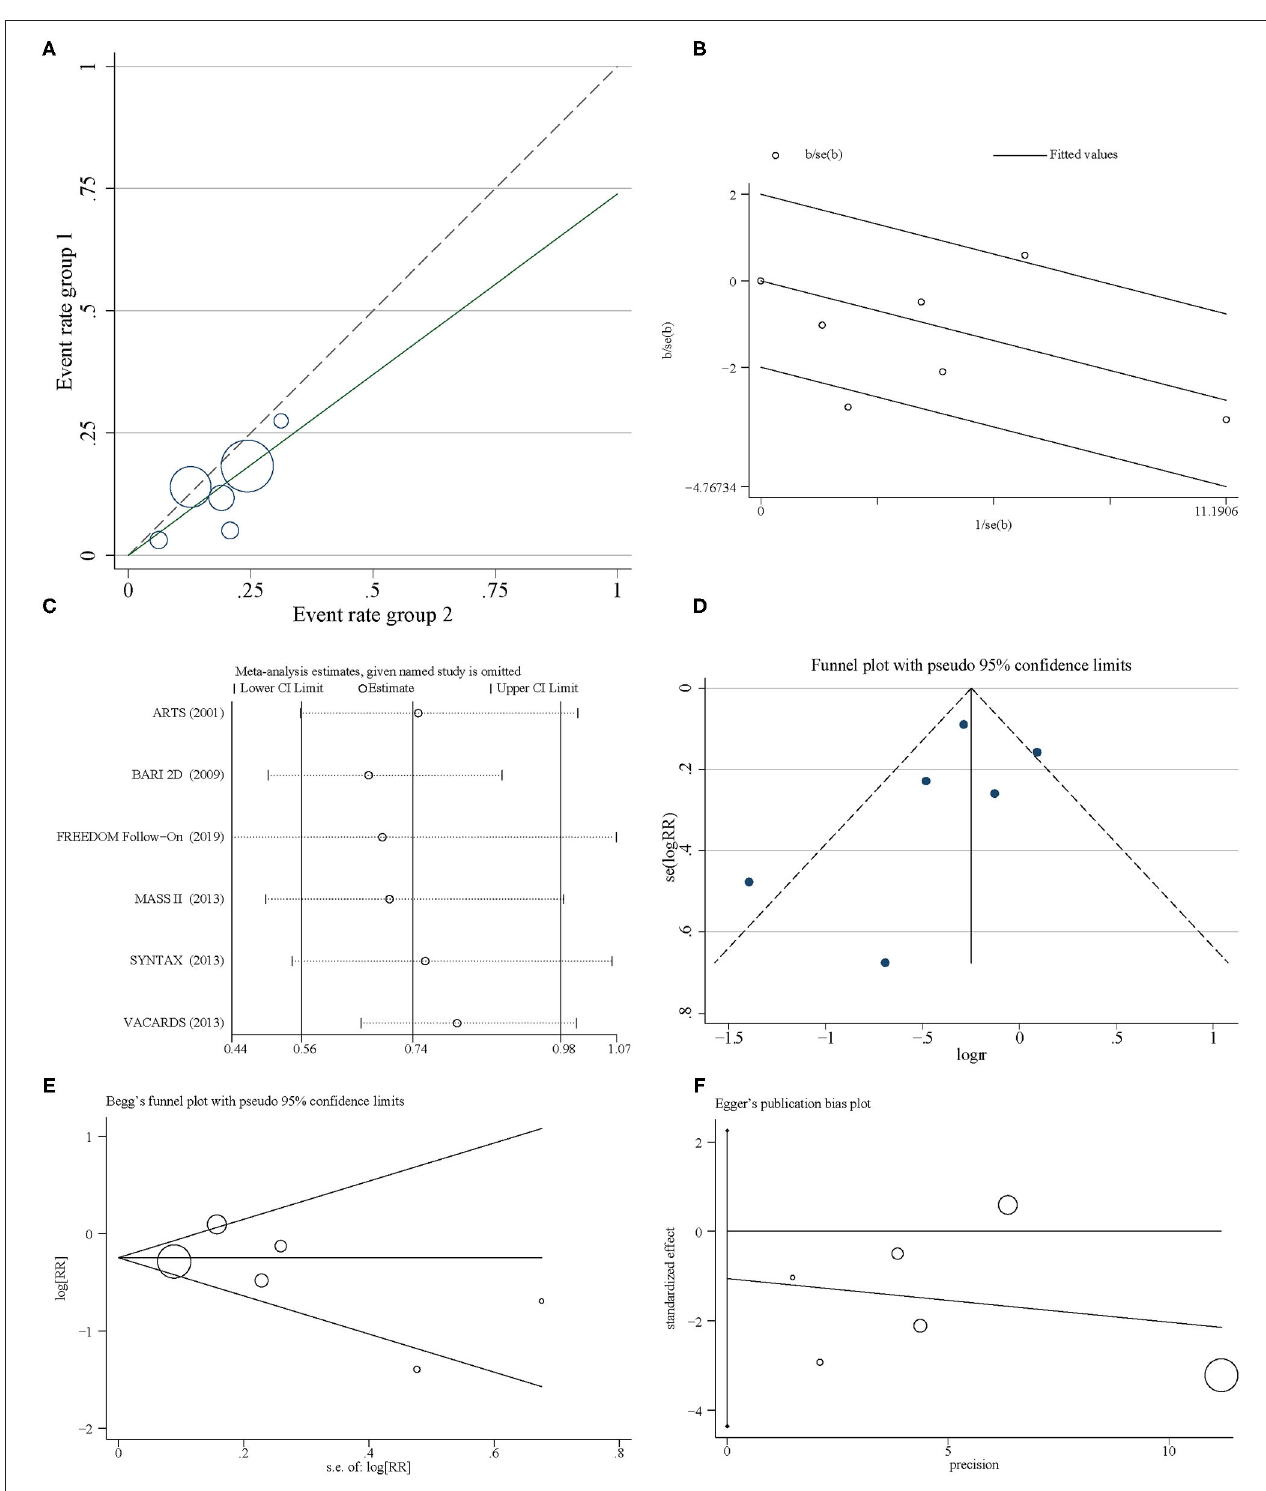
FIGURE 3 | Heterogeneity and sensitivity analysis. (A) L’Abbe plot. (B) Galbraith Radial plot. (C) Sensitivity analysis. (D) Funnel plot. (E) Begg’s plot. (F) Egger’s plot. T2DM revascularized by CABG compared with those patients compared with PCI are gradually reduced, but it has a higher revascularized by PCI, but a significantly higher risk of stroke rate of stroke. Recent studies comparing CABG with PCI in these studies, with no statistical significance (28, 47, found significantly lower mortality rates among patients with